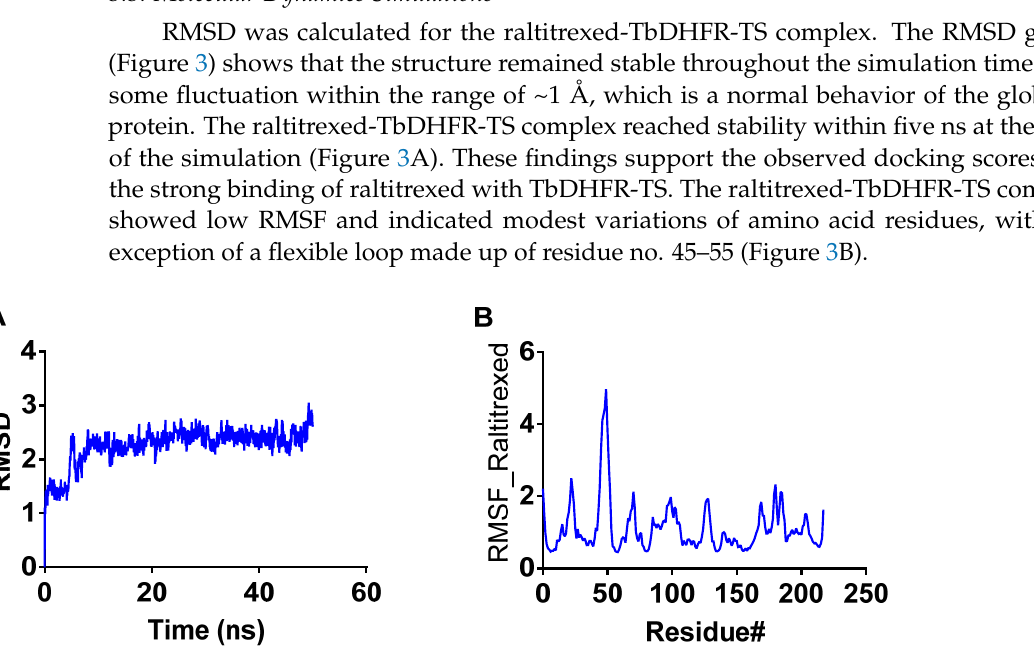
Figure 3. RMSD and RMSF of the interaction of raltitrexed with Trypanosoma brucei dihydrofolate reductase. ( A ) RMSD of raltitrexed for 50 ns. ( B ) RMSF of raltitrexed for 50 ns.